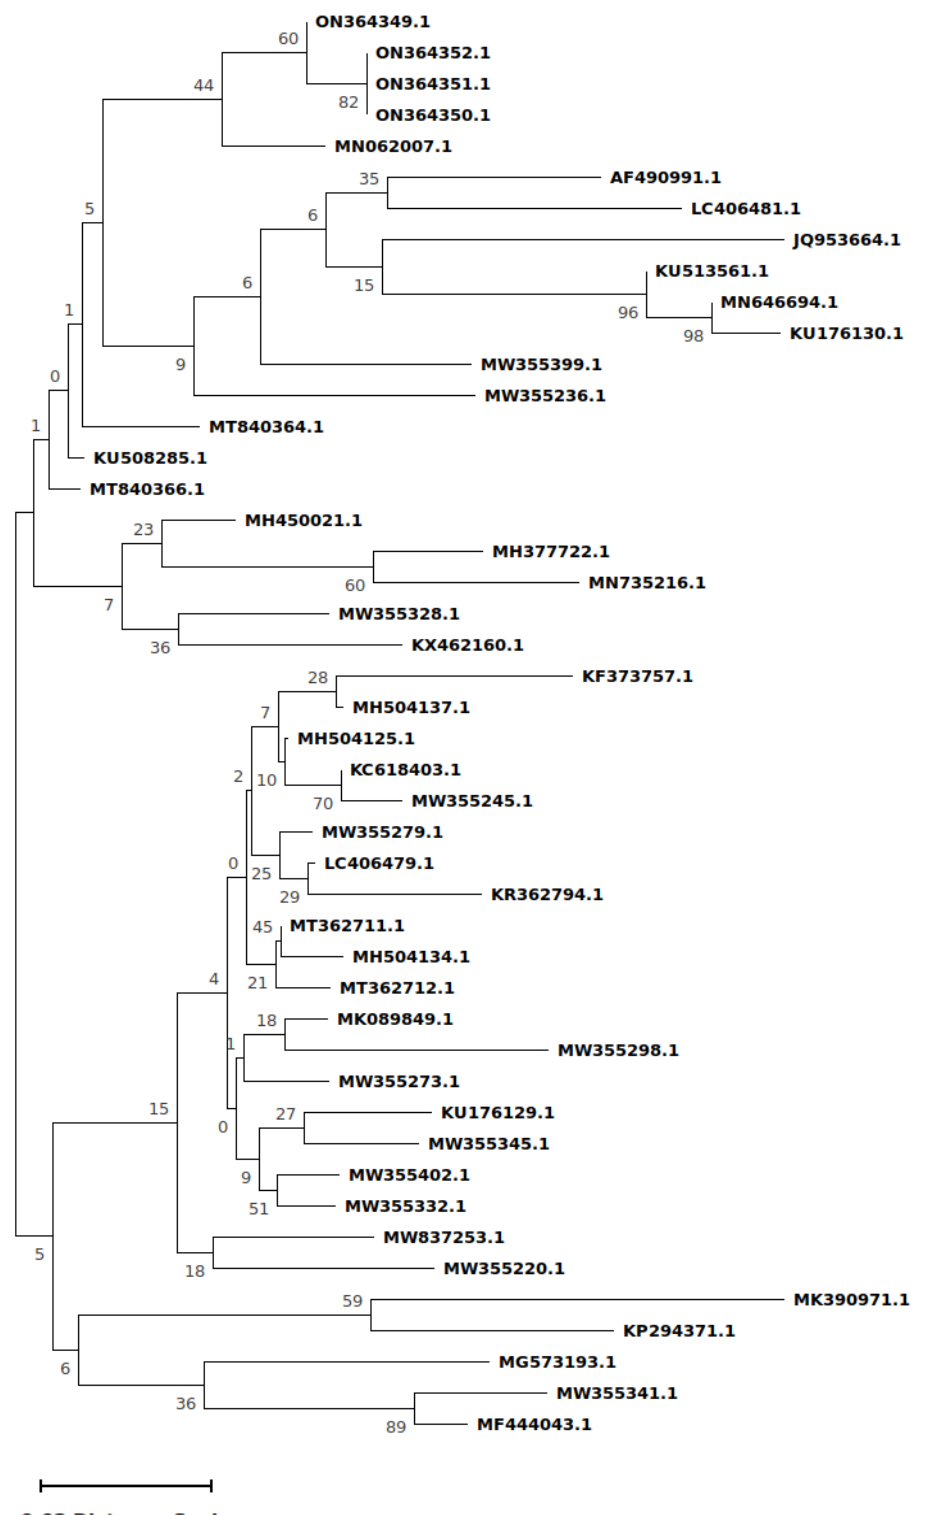
Figure 2. Neighbor-joining phylogenetic tree was constructed on the fragment of 145 bp, referring to the ORF2 from liver and muscle tissue samples and realized through the usage of p-distance model with bootstrapping of 1000 replicates. Sequence ON364349 was identified from muscle tissue (diaphragm) and the other ones ON364350, ON364351 and ON364352 from liver aliquots.